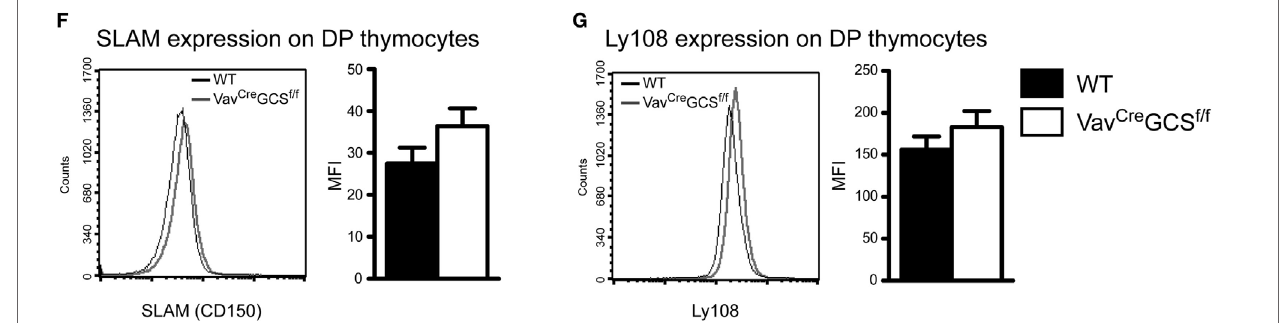
FigUre 4 | Vav Cre GCS f/f mice showed a typical thymocyte development and an unaltered expression of CD1d, SLAM and Ly108 molecules. (a) No statistically significant differences were observed between 8 week old WT and Vav Cre GCS f/f mice in terms of body weight and the weight and cellularity of spleen and thymus. Bars show means ± SEM, N = 6 per group. (B) Thymocyte development was investigated in 8 week old mice by flow cytometry using antibodies against CD4 and CD8. The double-negative (DN) stage was further subdivided into DN1 (CD25 – /CD44 + ), DN2 (CD25 + /CD44 + ), DN3 (CD25 + /CD44 – ), and DN4 (CD25 – /CD44 – ). Representative dot plots (upper panels) as well as relative and absolute numbers (lower panels) are shown (mean ± SEM, N = 13 per group). No statistically significant differences could be observed between WT and Vav Cre GCS f/f mice. (c) Frequencies of B (CD3 – /CD19 + ) and T (CD3 + /CD19 – ) cells were measured by flow cytometry in spleens of 8 week old mice. Representative dot-plots and quantifications are shown (mean ± SEM, N = 13 per group). No statistically significant differences could be observed between WT and Vav Cre GCS f/f mice. (D,e) Expression of CD1d was measured on DP (CD4 + /CD8 + ) thymocytes (D) and splenic DC (CD11c + /MHCII + ) (e) and expressed as mean fluorescence intensity (MFI). No statistically significant difference could be observed between WT and Vav Cre GCS f/f mice. Shown are means ± SEM, N = 6 per group in panel (D) and 4 per group in panel (e) . (F,g) Expression of SLAM (CD150) and Ly108, respectively, was measured on DP (CD4 + /CD8 + ) thymocytes and expressed as MFI. No statistically significant difference could be observed between WT and Vav Cre GCS f/f mice. Shown are means ± SEM, N = 4 per